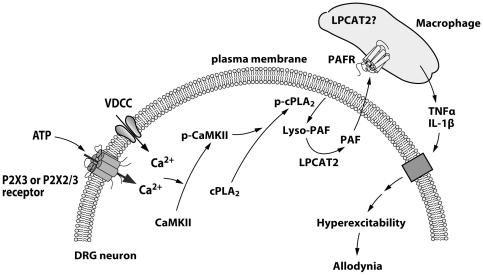
Schematic representation of the proposed mechanism underlying the PAF/PAFR system-mediated neuropathic pain after peripheral nerve injury.After peripheral nerve injury, cPLA2 is activated by Ca2+ signaling evoked by P2X3 or P2X2/3 receptors (subtype of ionotropic purinergic receptors) and voltage-gated Ca2+ channels (VDCC). The Ca2+-dependent cPLA2 activation involves Ca2+/calmodulin-dependent protein kinase II (CaMKII). cPLA2 supply lyso-PAF which in turn converts into PAF by the lyso-PAF-acetyltransferase LPCAT2. PAF activates PAFR expressed in macrophages. Activation of PAFR may lead to production and release of proinflammatory cytokines, TNFα and IL-1β. These cytokines may increase the excitability of DRG neurons that link to nerve injury-induced tactile allodynia.